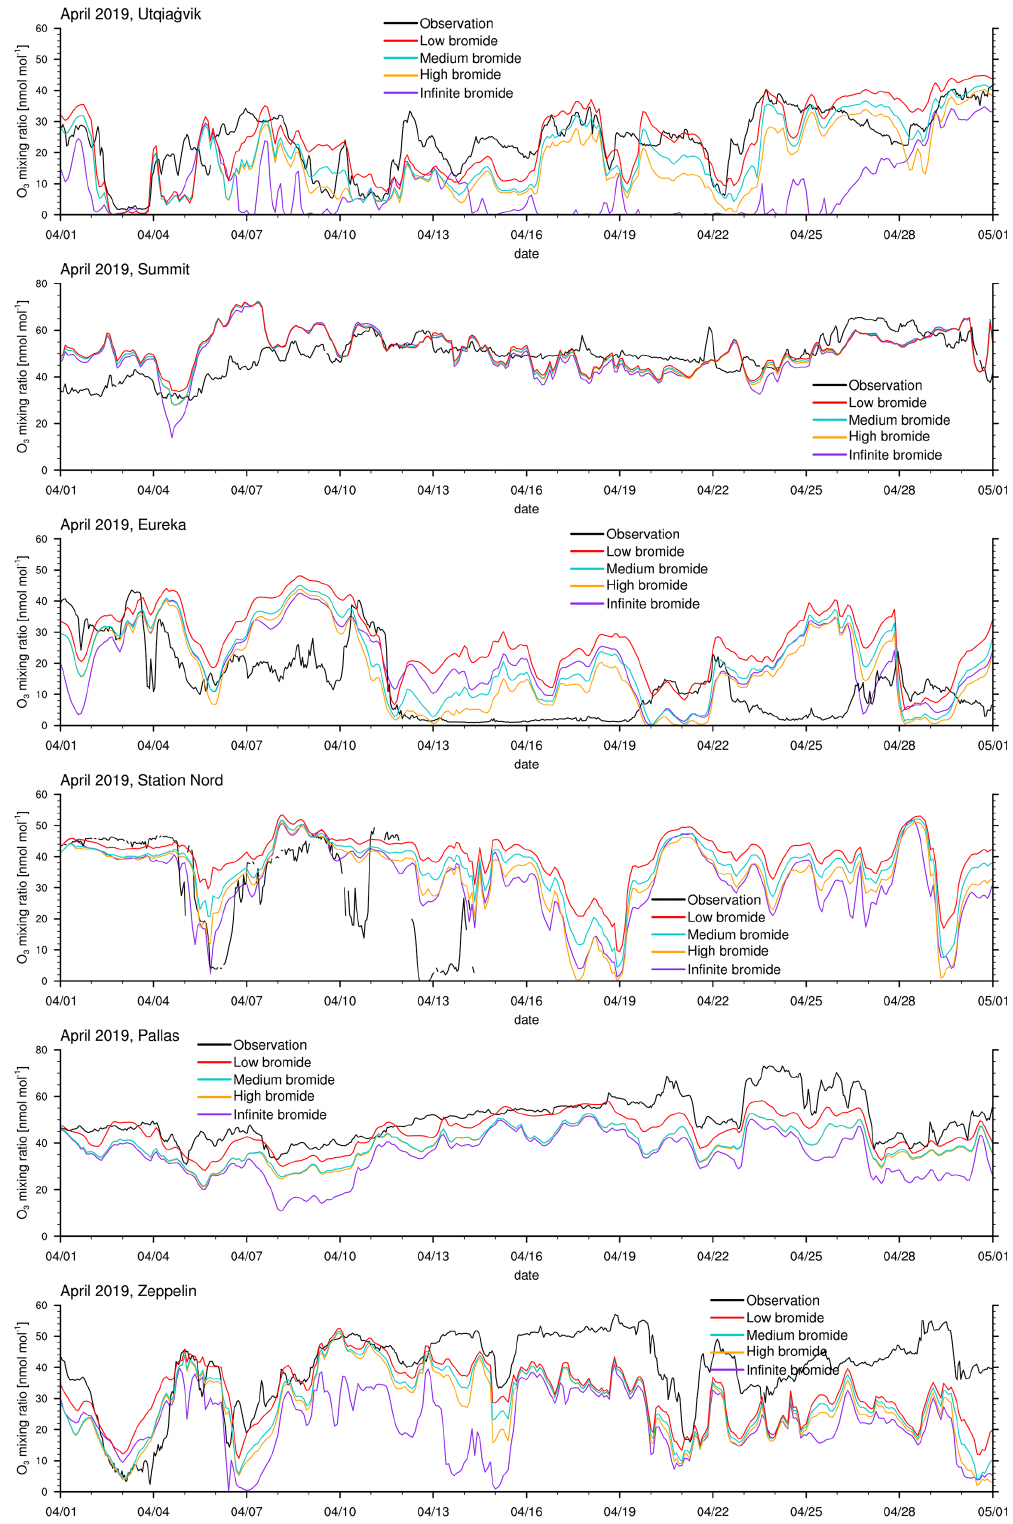
Figure 4. Modeled and observed ozone during April at Utqia˙gvik, Summit, Station Nord, Pallas, and Zeppelin Mountain from top to bottom.